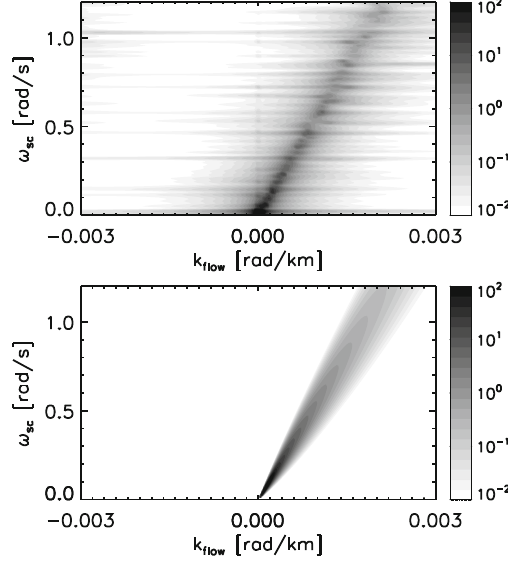
Fig. 9 Energy spectrum for magnetic field fluctuations in the streamwise wavenumber– frequency domain obtained from the Cluster spacecraft data in the solar wind (top) and reconstruction after a fitting in the mean flow velocity and the root-mean-square flow velocity. Image reproduced